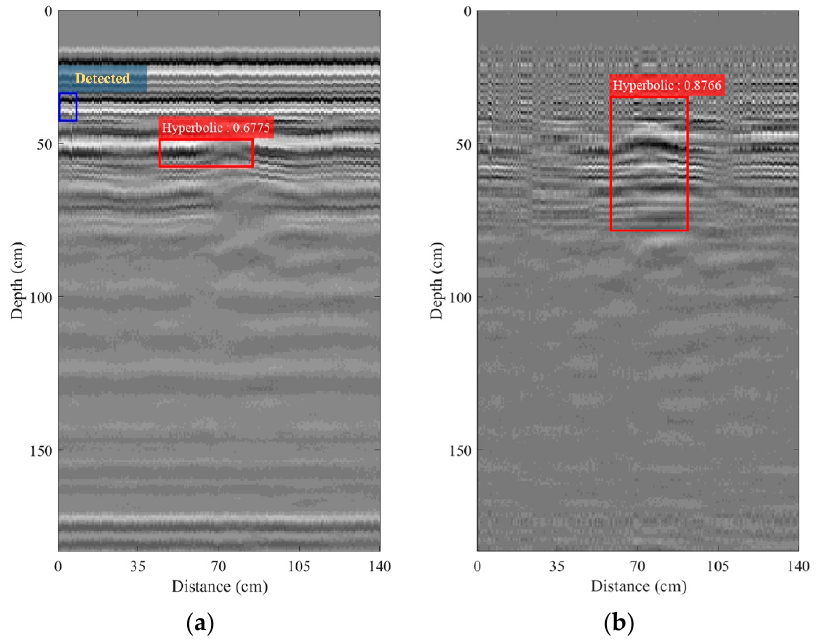
Figure 16. B-scan images collected using the maintenance train-mounted GPR system on the railway: ( a ) without any pre-processing; ( b ) with zero offset and background removals.